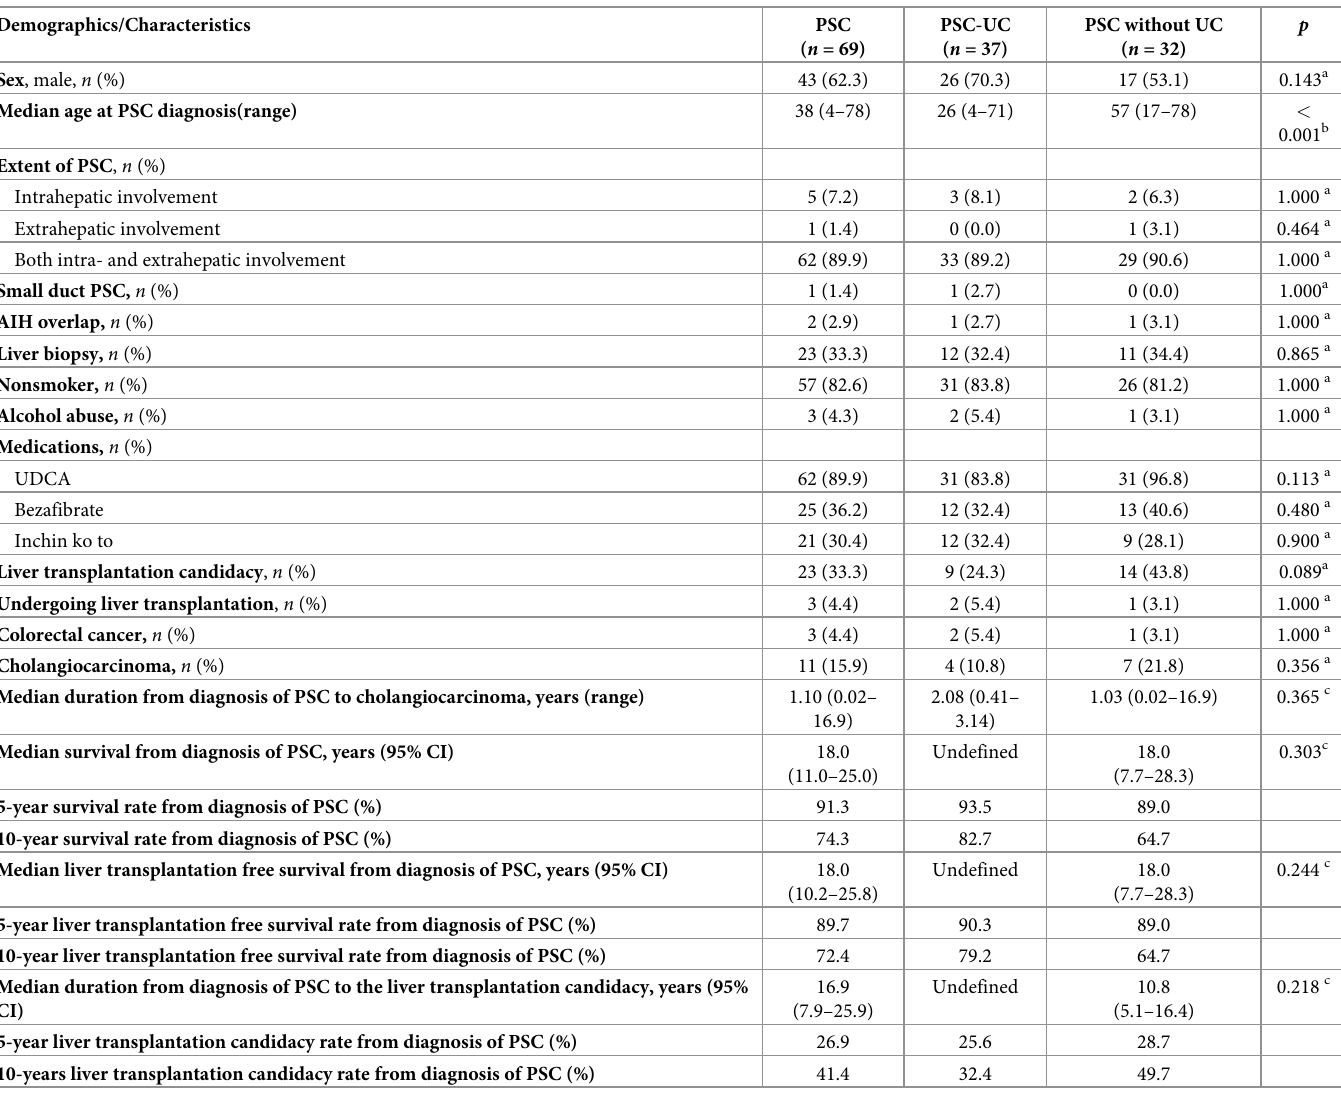
Table 1. Patients’ characteristics and outcomes of